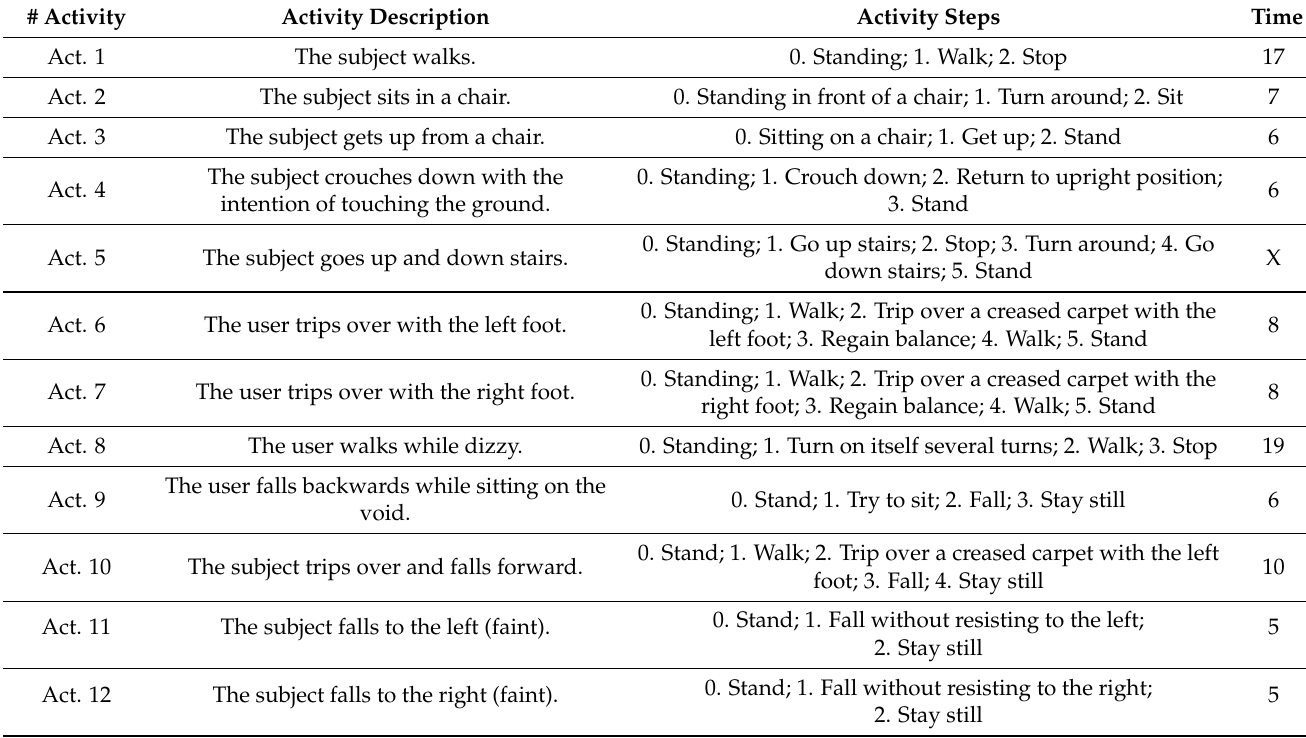
Table 3. List of recorded activities. Last column indicates the mean execution time (in seconds) for each